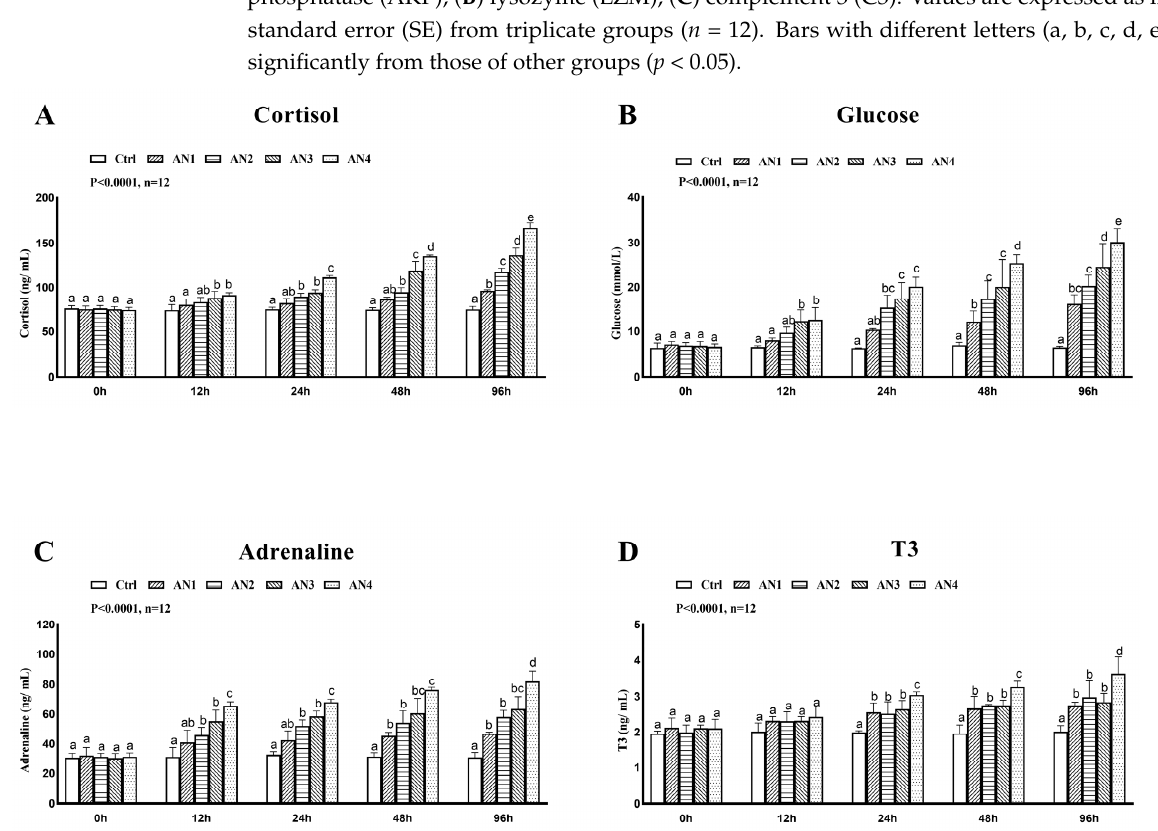
Figure 6. Changes of heat shock protein content and gene expression of bighead carp exposed to ammonia. ( A ) Heat shock protein 70 (HSP70), ( B ) relative Hsp70 mRNA expression, ( C ) heat shock protein 90 (HSP90), and ( D ) relative Hsp90 mRNA expression. Values are expressed as mean ± stand- ard error (SE) from triplicate groups ( n = 12). Bars with different letters (a, b, c, d) differ significantly from those of other groups ( p < 0.05). 3.6. Antioxidant Responses At 24 h, 48 h, and 96 h after exposure to ammonia, T-AOC in the AN1, AN2, AN3, and AN4 groups decreased significantly, Figure 7D. ROS was significantly increased in the AN2, AN3 and AN4 groups at 12 h, 24 h, 48 h, and 96 h of ammonia exposure, Figure 7E. In the AN1 group, SOD activity was significantly increased in the AN1 group at 48 h of ammonia exposure, and decreased to no significant difference with the control group at 96 h of ammonia exposure. In the AN2 group, SOD activity was significantly increased